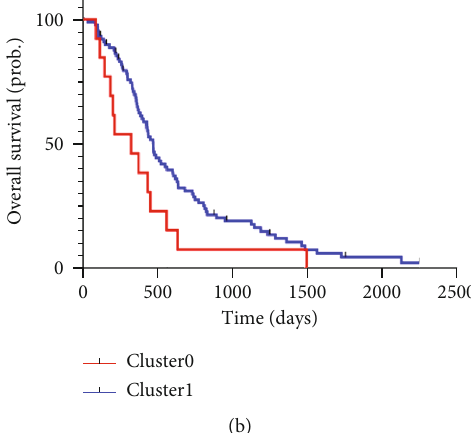
Figure 3: Hierarchical clustering was used to determine the expression pattern of the 31-gene signature on the samples from TCGA (Figure 3(a)). The samples in the red branch on the left side of the dendrogram are classi fi ed as Cluster0, while the samples in the blue branch on the right side are classi fi ed as Cluster1. After using Kaplan-Meier survival analysis, the prognosis of Cluster0 is di ff erent from that of Cluster1, so according to Kim et al. ’ s report, Cluster0 was subclassi fi ed as the radiotherapy resistance group (RR), whereas Cluster1 was a radiotherapy e ff ective group (RE) (Figure